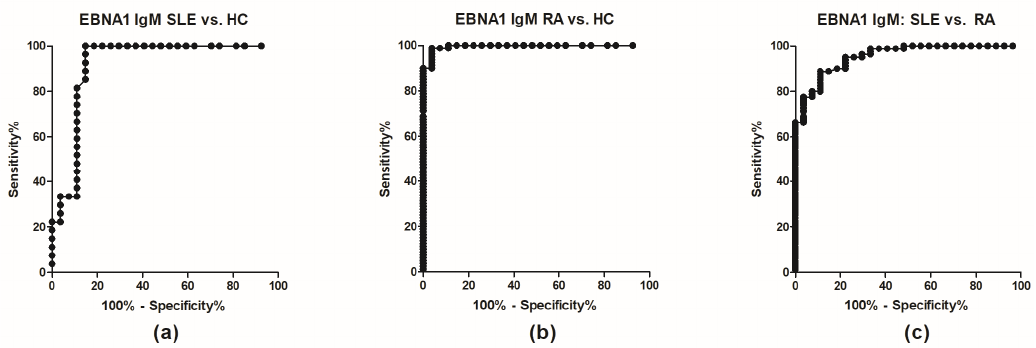
Figure 2. ROC curves for Epstein-Barr nuclear antigen 1 IgM in systemic lupus erythematosus (SLE), rheumatoid arthritis (RA) and healthy control (HC) sera. ( a ) SLE vs HC; ( b ) RA vs HC; ( c ) SLE vs RA. Epstein-Barr virus nuclear antigen 1; HC, healthy control; RA, rheumatoid arthritis; SLE, systemic lupus erythematosus.